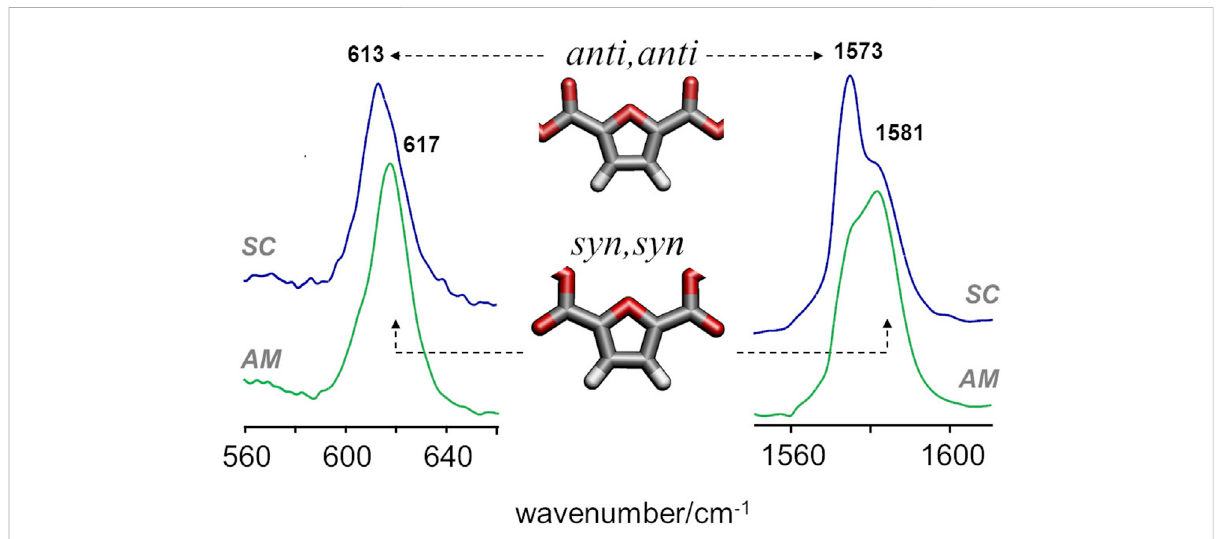
FIGURE 5 FTIR-ATR spectra of semicrystalline (top) and amorphous (bottom) samples of PBF, with identi fi cation of the bands sensitive to syn − anti